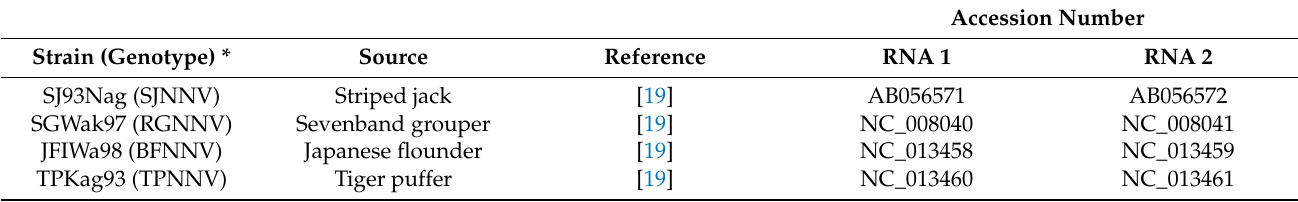
Table 1. Betanodavirus strains and genome sequences used in this